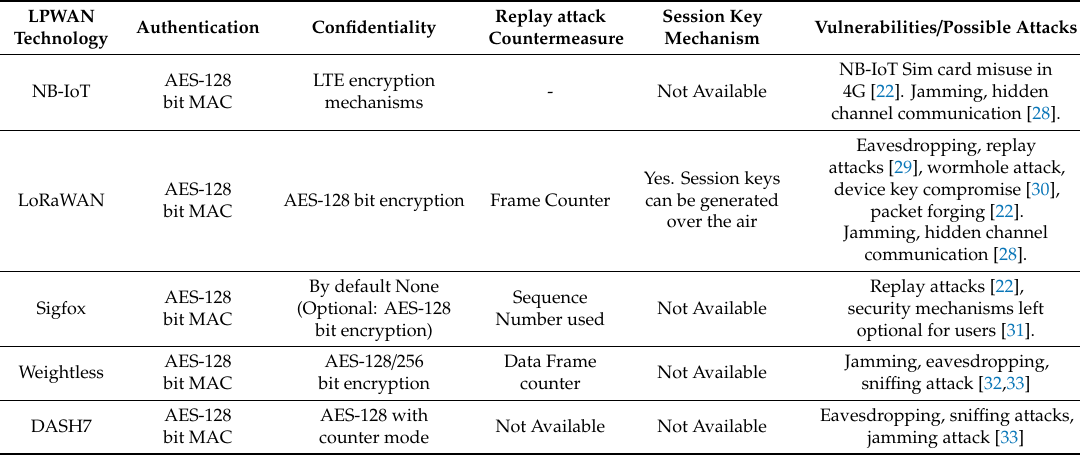
Figure 3. Encryption and message signing in LoRaWAN.